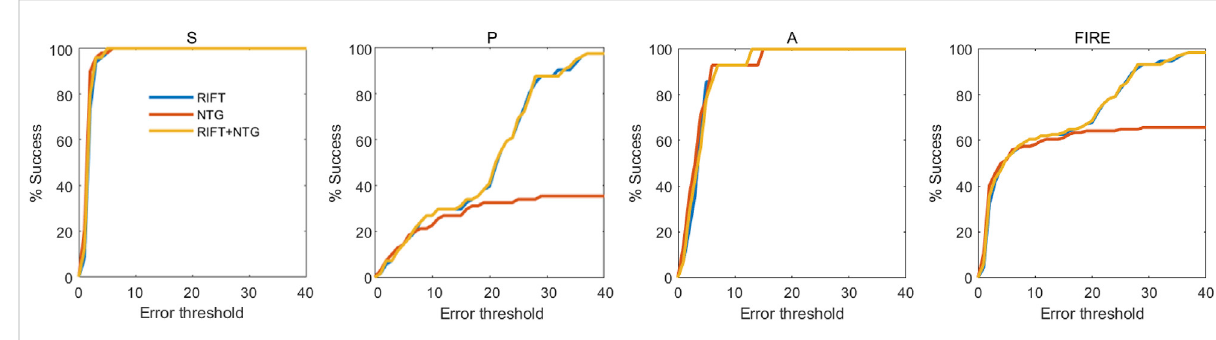
FIGURE 2 Registrationsuccessplotoftheablationstudy.The x -axismarks,inpixels,theregistrationerrorthresholdunderwhichregistrationisconsidered to be successful. The y -axis marks the percentage of successfully registered image pairs for a given